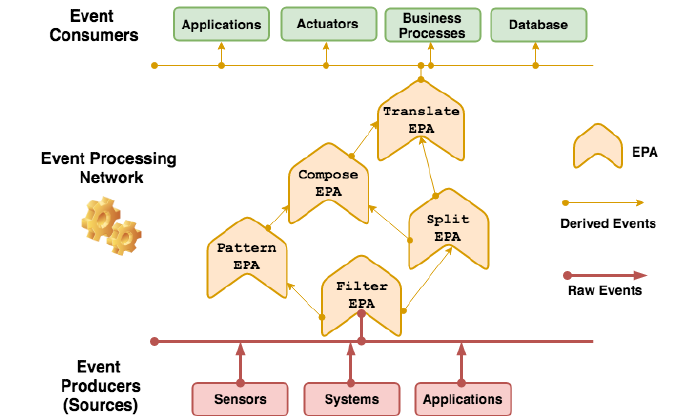
Figure 1. Event Processing Network (EPN)